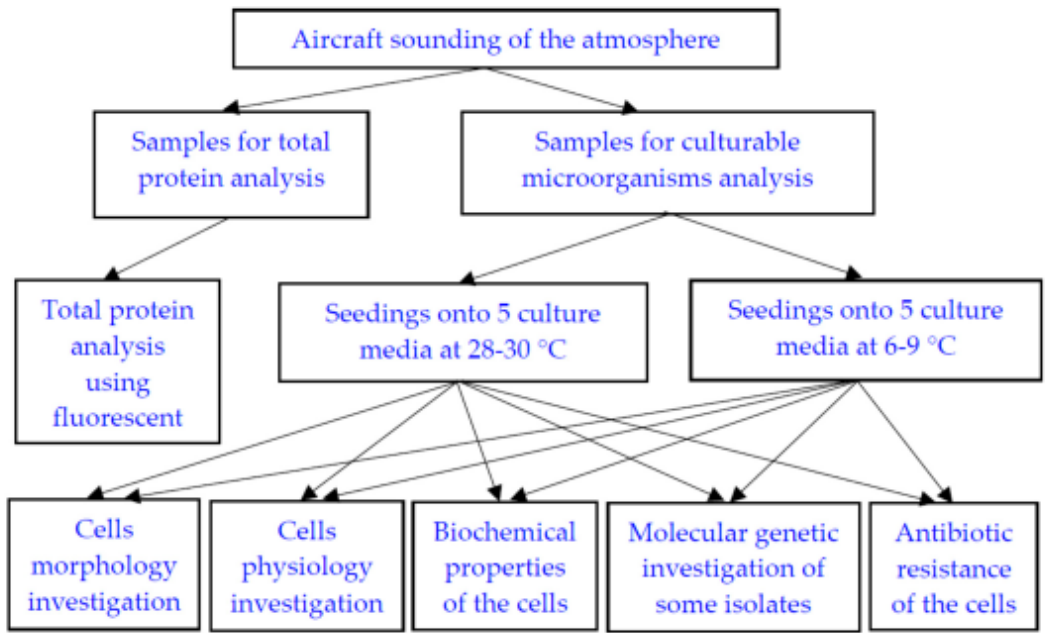
Figure 2. The flow chart of the